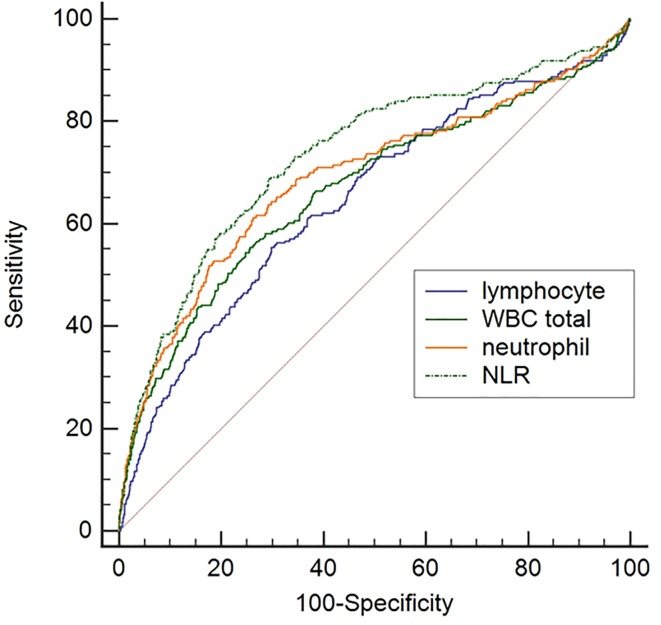
Comparison of receiver operating characteristic (ROC) curves for expecting indeterminate results in 2773 QuantiFERON-TB Gold In-Tube assays.The difference of area-under-the-curve (AUC) between neutrophil-to-lymphocyte ratio (NLR) (AUC;0.73) and neutrophil count (AUC;0.69), total WBC count (AUC;0.67), and lymphocyte count (AUC;0.65) was significant.